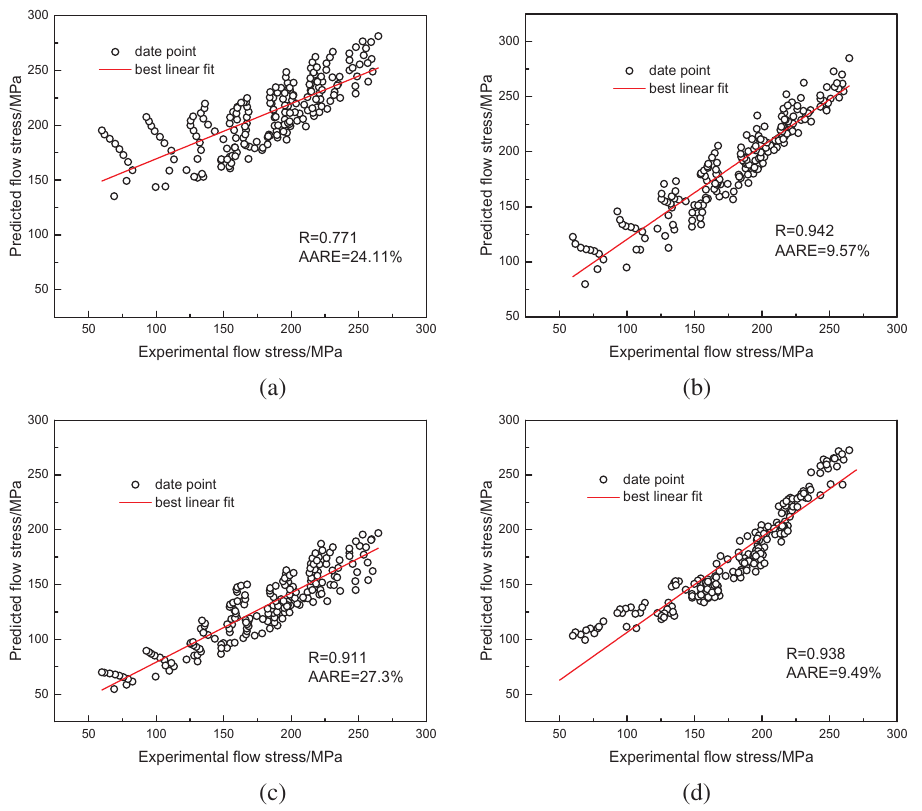
Figure 21: Correlation between the experimental and predicted flow stress values from (a) Johnson – Cook model, (b) modified Johnson – Cook model, (c) modified ZA model, (d) the strain-compensated Arrhenius-type